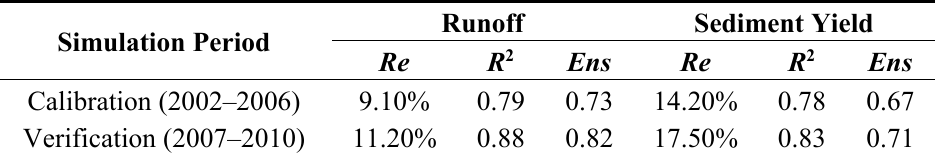
Figure 8. Comparison between the simulated and observed monthly sediment yield in model validation. Table 3. Evaluation results of the SWAT model